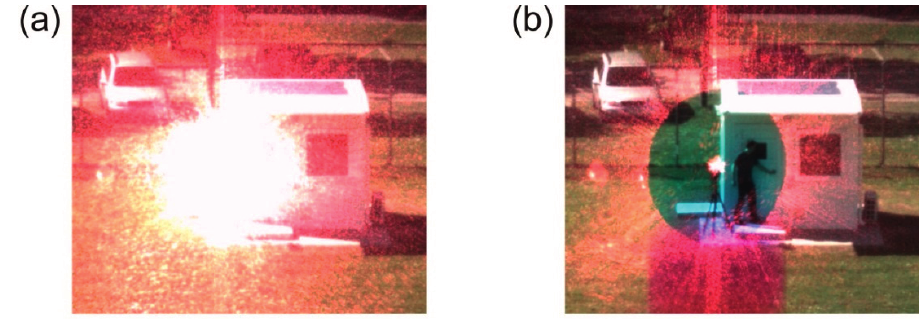
Figure 4. ( a ) Disturbed scene: Laser radiation dazzles the camera. Filtering of dazzling laser light is deactivated. ( b ) View of the scene when the filtering of dazzling laser light is activated. As a side effect, a vertically arranged color distortion is recognizable, but the geometrical details are